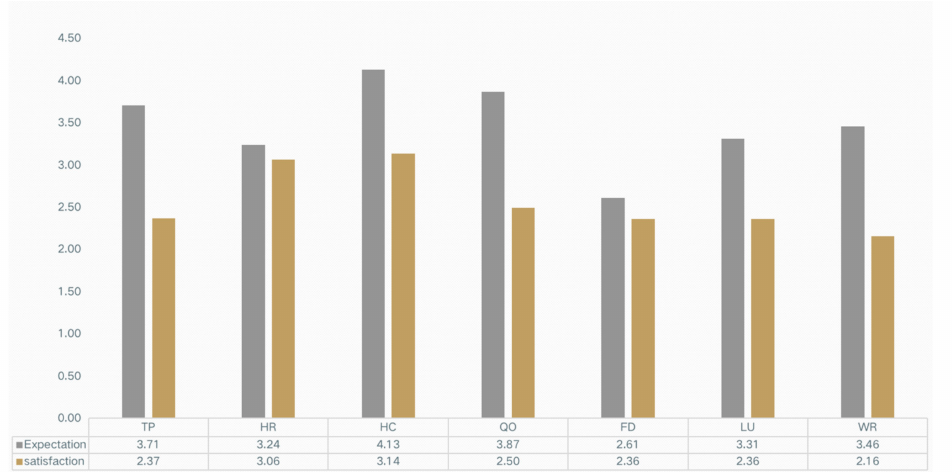
Figure 4. Comparison of the satisfaction and expectations of the functional